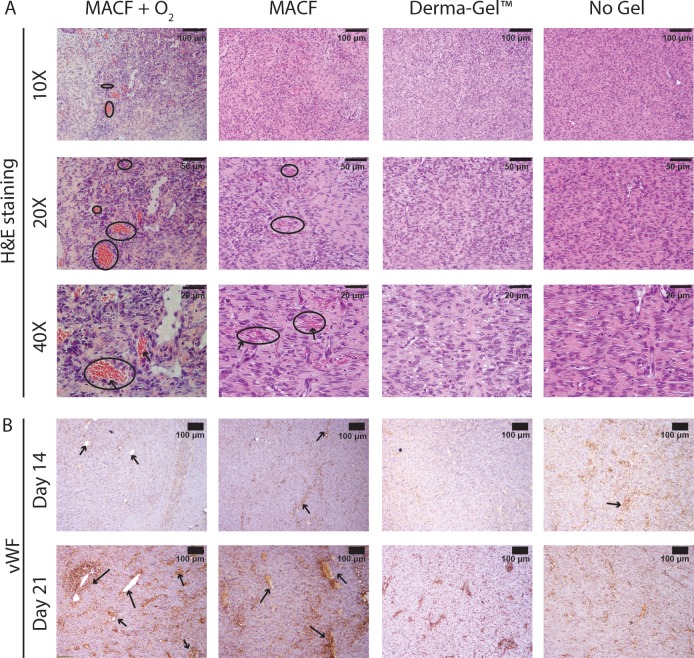
Oxygenated hydrogel treatments may help sustain neovascularization.A) H&E staining reveals circulating blood cells (arrows) in capillaries (circled). B) Von Willebrand factor immunostaining on wound tissue sections to mark (arrows) newly formed capillaries. Representative images for all wound regions.